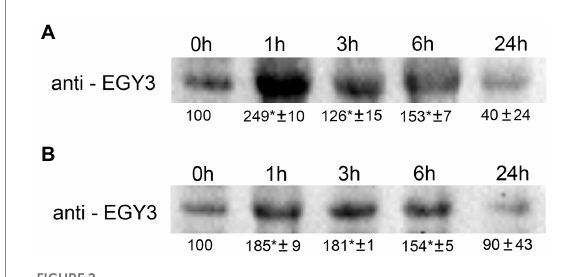
FIGURE 2 Immunoblot quantification of EGY3 protein in wild-type plants (WT) under high-temperature stress (A) and during an exposition to high light conditions (B) . The plants were exposed for 1 h, 3 h, 6 h, and 24 h for 40 ° C to cause high-temperature stress and for 1,000 μ mol m − 2 s − 1 to cause high light stress. “±” means standard deviation, the asterisk means the significant difference in comparison to 0 h time (no stress).